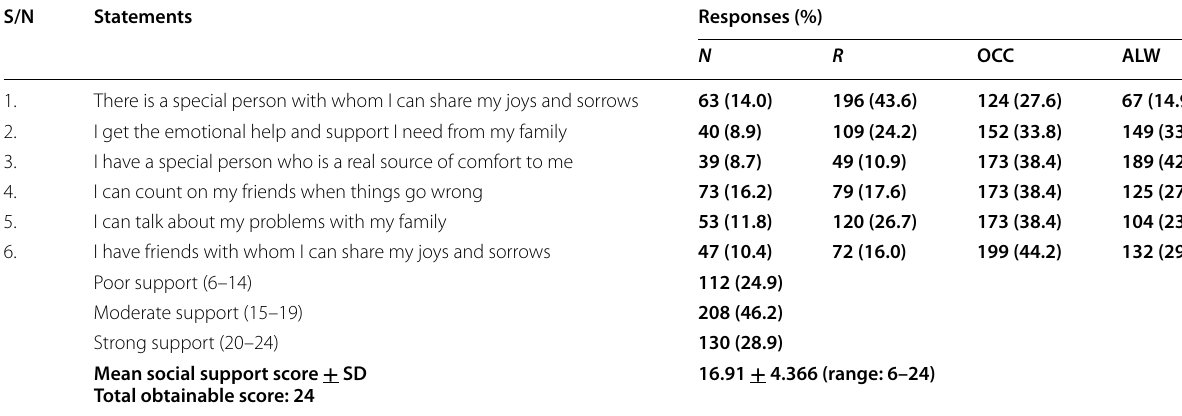
Table 4 Social support of study